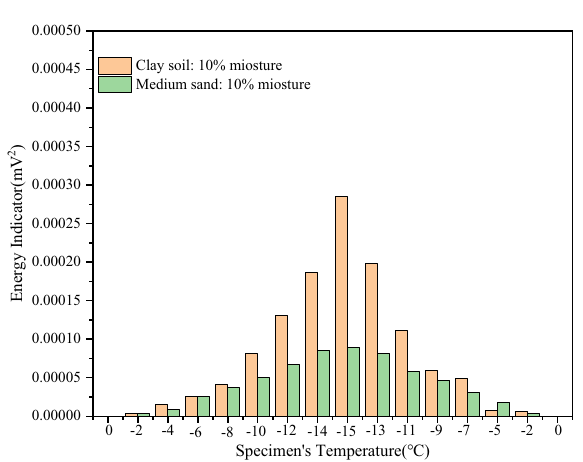
Figure 9. Energy indicator diagram of samples with different moisture content. ( a ) Energy indicator of clay samples with different moisture content; ( b ) energy indicator of sand samples with different water content.